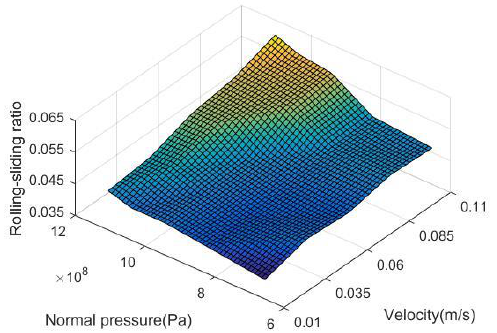
Figure 6. Rolling-sliding ratio between spherical roller and track.